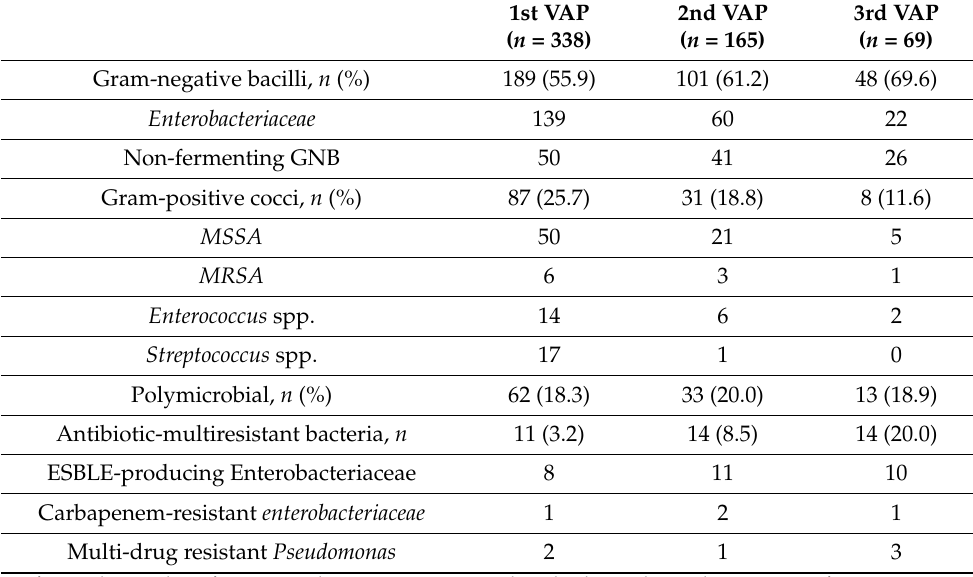
Table 3. Micro-organisms responsible for VAP (1st episode and